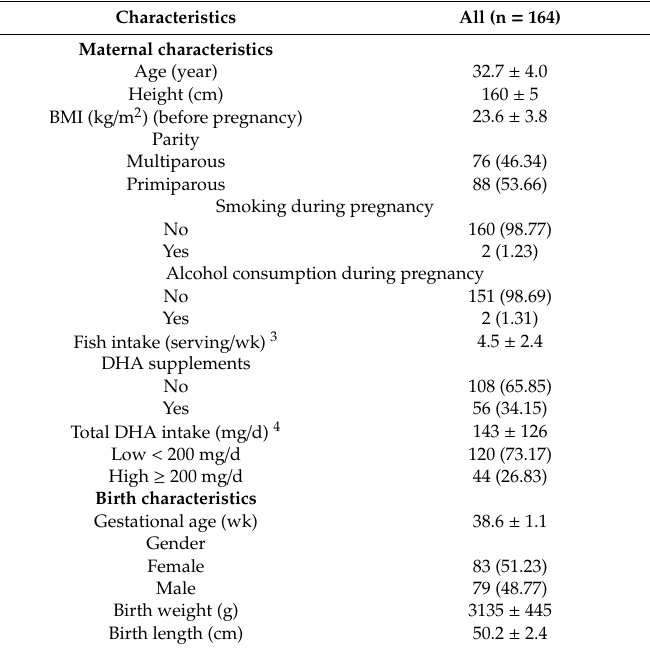
Table 1. Characteristics of study participants 1,2